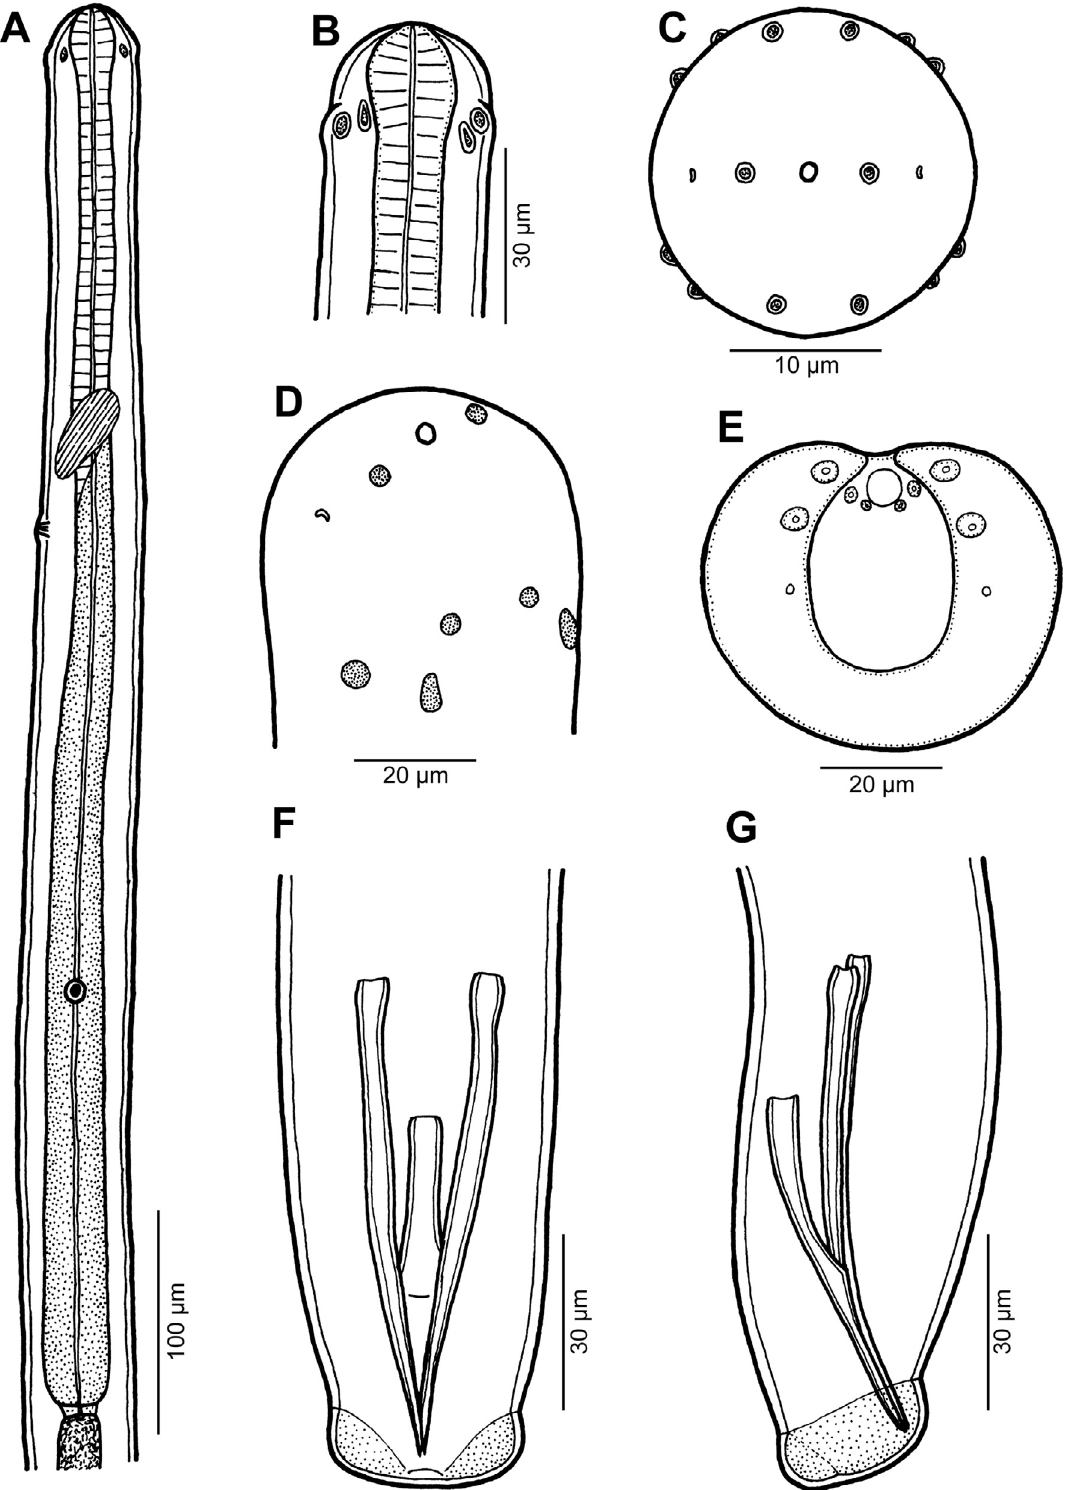
Figure 8. Male of Philometra selaris n. sp. from Selar crumenophthalmus . A: Anterior end of body, lateral view. B, C, D: Cephalic end, lateral, apical and sublateral views, respectively. E: caudal end, apical view. F, G: Posterior end, ventral and lateral views,